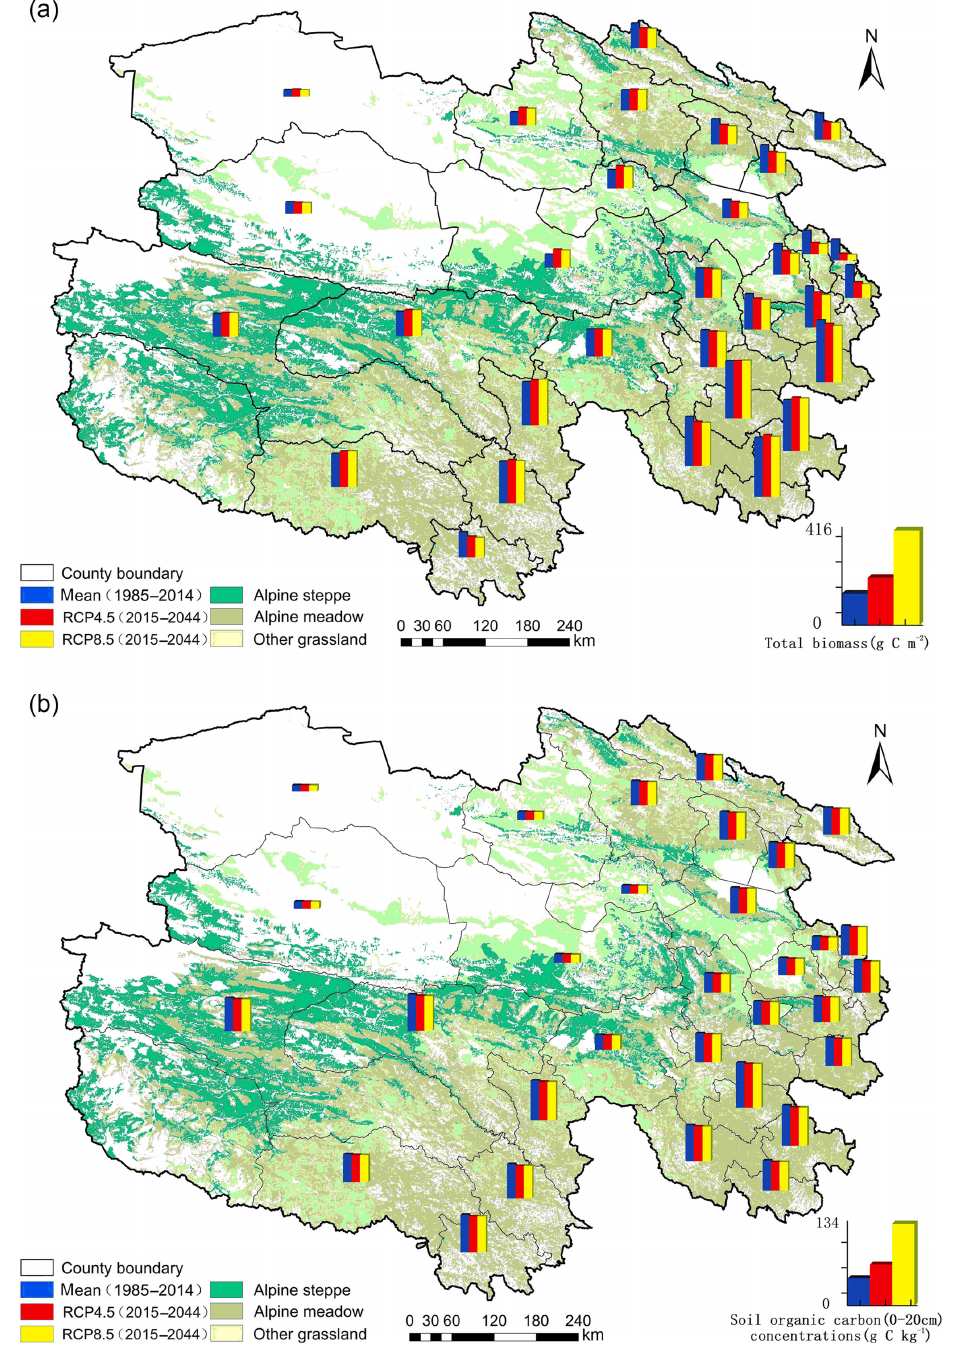
Figure 7. Responses of the grassland biomass (a) and SOC (b) to climate change at a regional scale.